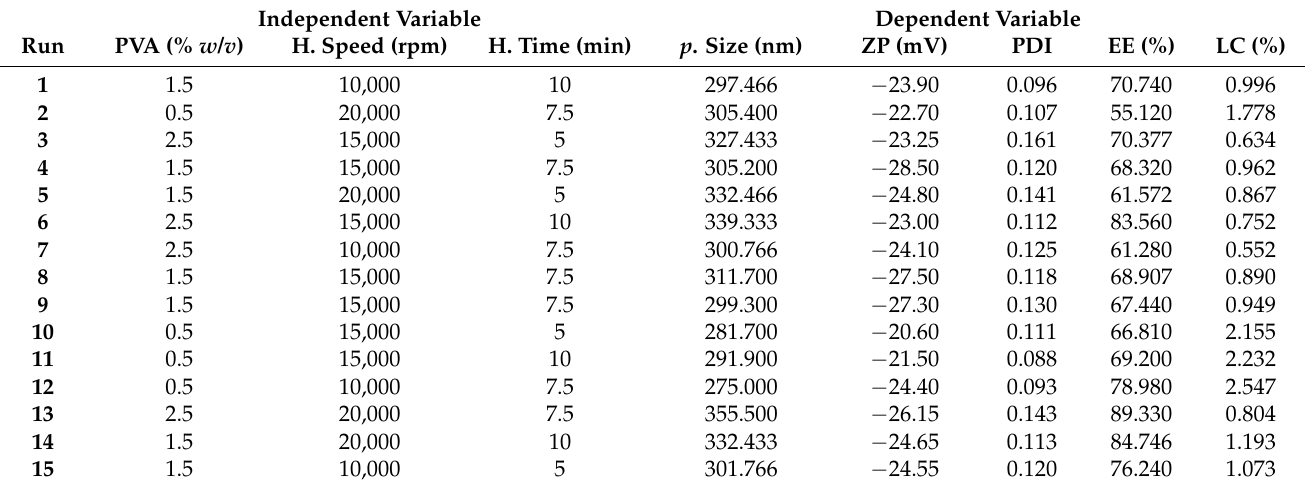
Table 2. Experimental matrix and observed responses from randomized runs in